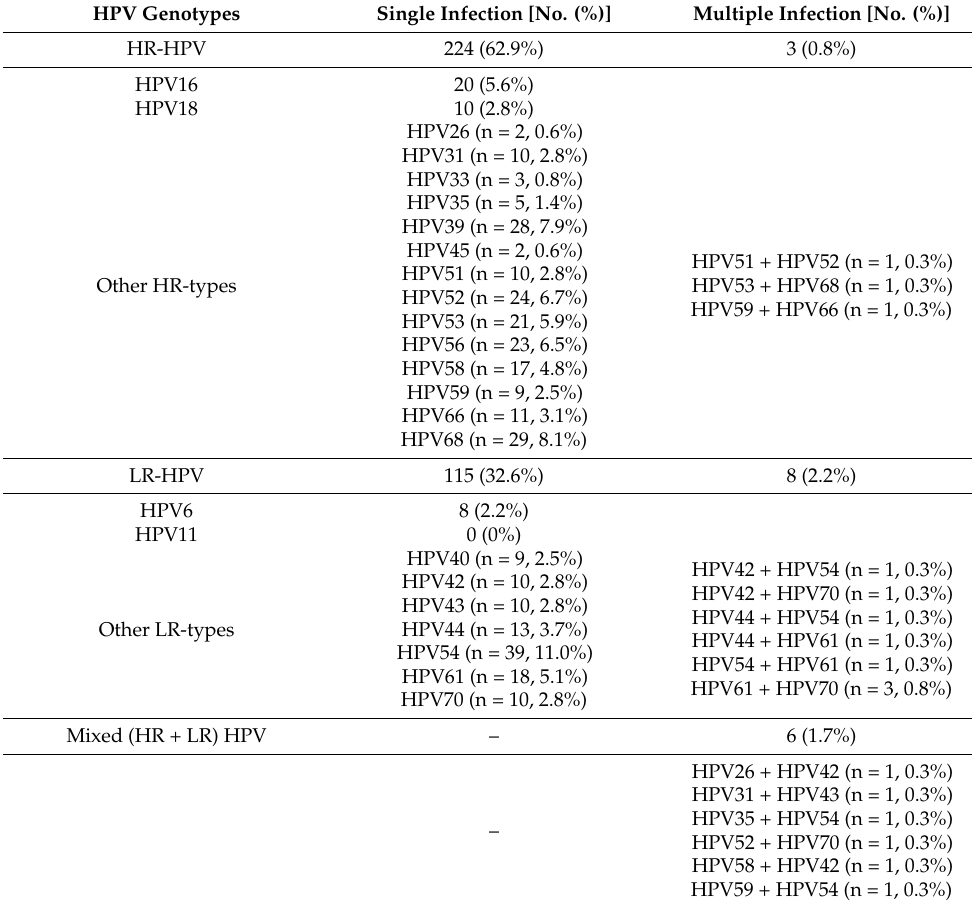
Table 2. Baseline HPV types in patients with low (1+) VL of HPV.